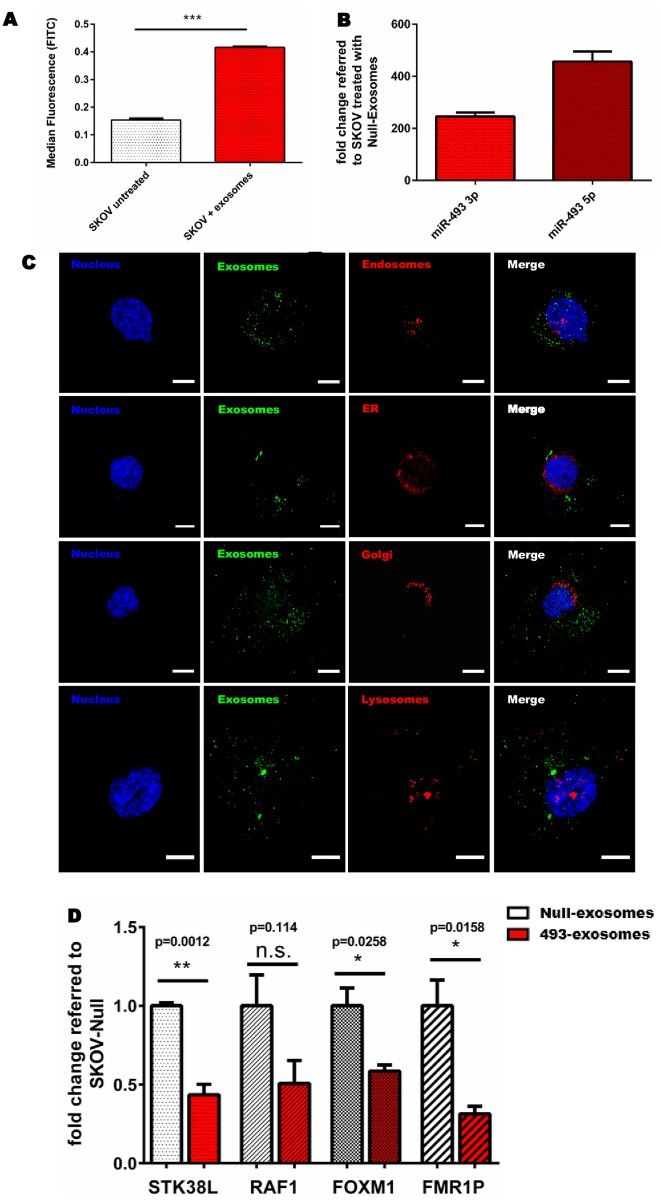
Uptake of exosomes from non-tumorigenic origin by ovarian cancer SKOV3 cells.(A) Flow cytometric analysis of GFP-positive SKOV3 cells after co-culturing with CD63-GFP containing exosomes. Significance was calculated employing unpaired t-test [n = 3 replicates; mean ± SD; ****p<0.0001]. (B) qPCR on SKOV3 cells, co-cultured with miRNA-493 pre-loaded CAP exosomes. Fold change calculations referred to miRNA-Null exosomes treated SKOV3 cells. U6 served as loading control. (C) Confocal microscopy images of SKOV3 cells stained for organelle marker proteins after treatment with CD63-GFP containing exosomes. DAPI (blue) indicates nucleus staining, GFP (green) represents exosomes and Alexa647 (red) shows organelle staining of endosomes, endoplasmic reticulum, golgi and lysosomes. Scale bar represents 10 μm. (D) qPCR on miRNA-493 target genes STK38L, RAF1, FOXM1 and FRM1P in SKOV3 cells, after exosome co-culturing for 72 h. SKOV3 cells were treated with miRNA-Null and miRNA-493 loaded exosomes all 24 h with 250 μg exosomal protein. PPIA served as loading control. Significance was determined by unpaired t-test [n = 3 replicates; mean ± SD; n.s. = not significant; *p<0.05, **p<0.01].